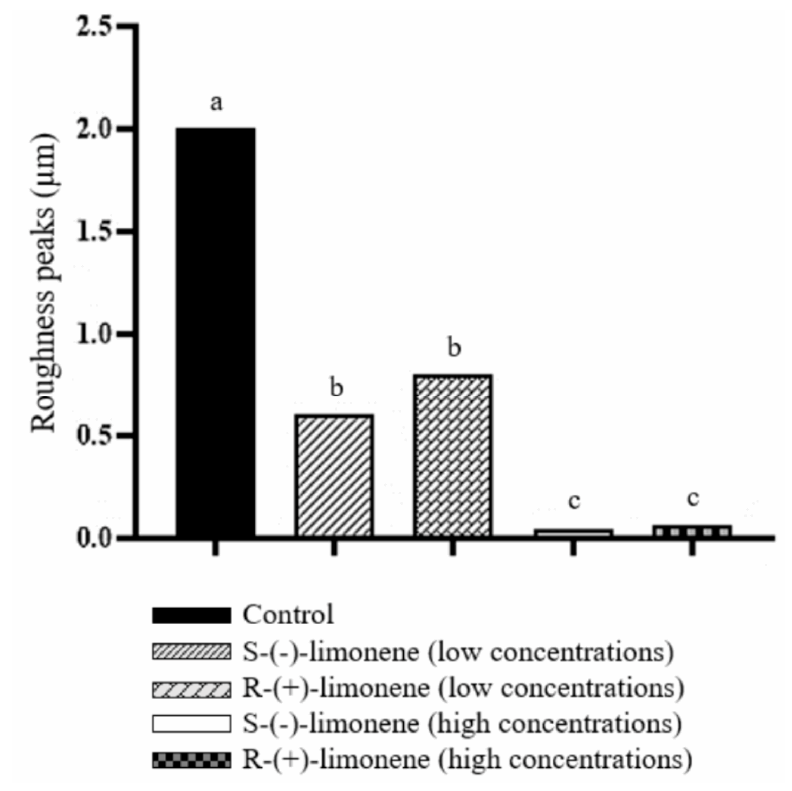
Figure 2. Effect of S-(-)-limonene and R-(+)-limonene on the inhibition of A. hydrophila biofilms in rectangular nylon blocks. Data are shown as the mean ± standard error. One-way analysis of variance and Tukey test, p < 0.05. Distinct letters indicate a significant difference between treatments.